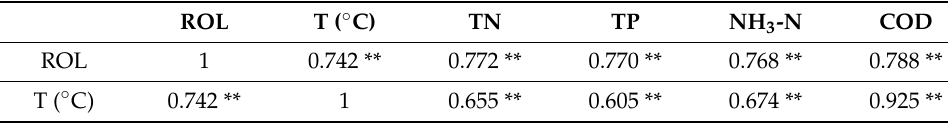
Table 1. Correlation analysis of ROL and water quality indexes. ROL T ( ◦ C) TN TP NH 3